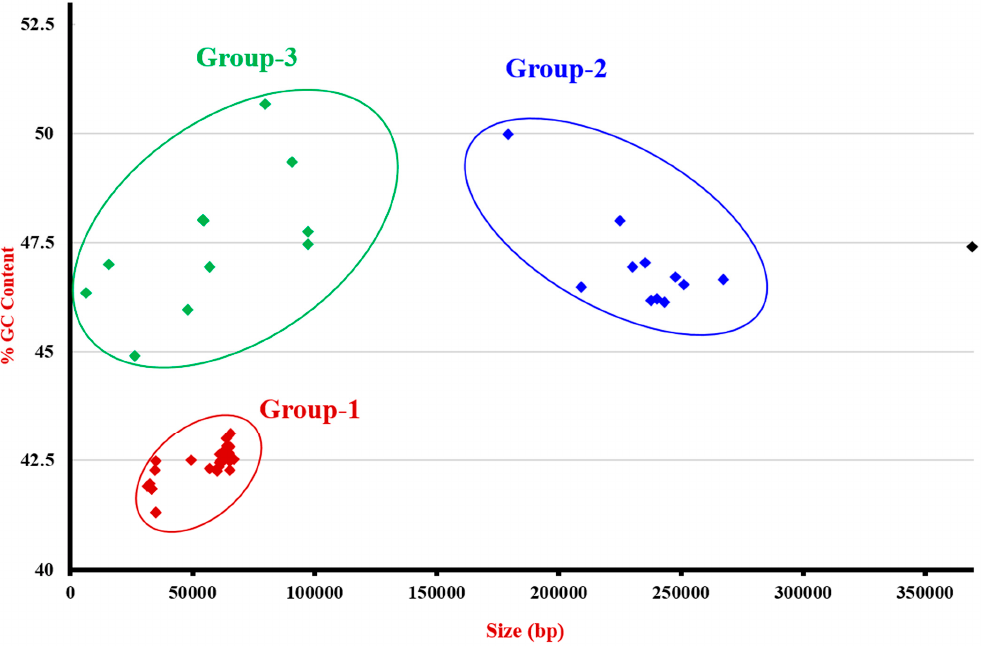
Figure 2. Diversity of plasmids carrying the mcr-1 gene. All of these plasmids were retrieved from the NCBI database and were plotted according to their GC% and size. Group-1 includes plasmids from E. coli , C. sakazaki , K. pneumoniae , K. ascorbata , S. enterica , and S. sonnei. The average size and %GC were estimated as 51.88-Kb and 41.32 GC%, respectively. The identified incompatibility plasmid types were IncI2, IncX4. Group-2 includes plasmids from E. coli only. The average size and %GC content were 244.81-Kb and 47.02 %GC, respectively. The incompatibility plasmid types of this group were: IncHI1B, IncHI2, IncFIB, IncN. Group-3 includes plasmids from E. coli , K. pneumoniae , and S. enterica. Their sizes varied from 6. 39 to 97.56-Kb and the GC% content from 44.89 to 50.57%. The incompatibility plasmid types of this group were IncFII, IncX4, IncFIB, IncY. A single plasmid from E. coli (in black) with size of 369.30-Kb, 47.4% of GC content, and belonging to the IncN plasmid type was identified.